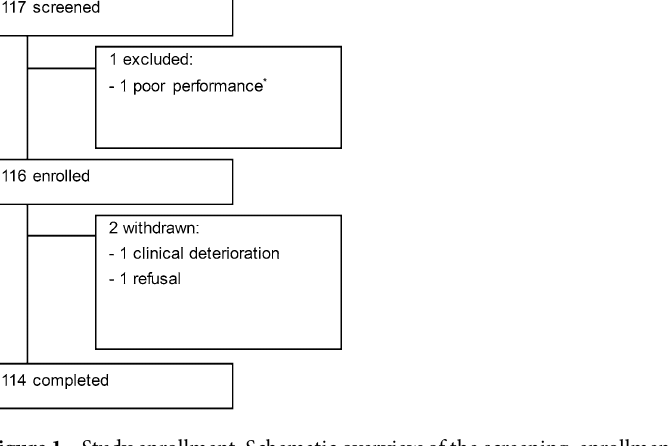
Figure 1. Study enrollment. Schematic overview of the screening, enrollment, and follow-up of the study participants. *Eastern Cooperative Oncology Group-Performance Status (ECOG-PS) > 2 or Karnofsky Performance Status (KPS) < 70.